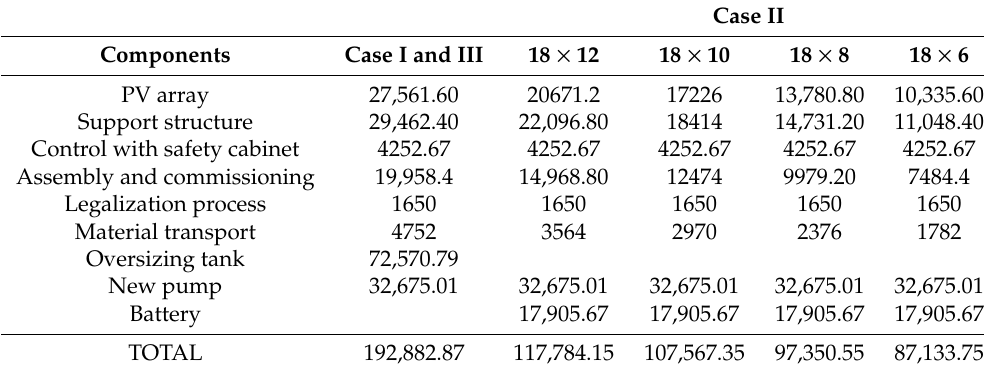
Table 6. Investment I 0 (EUR) for the analyzed